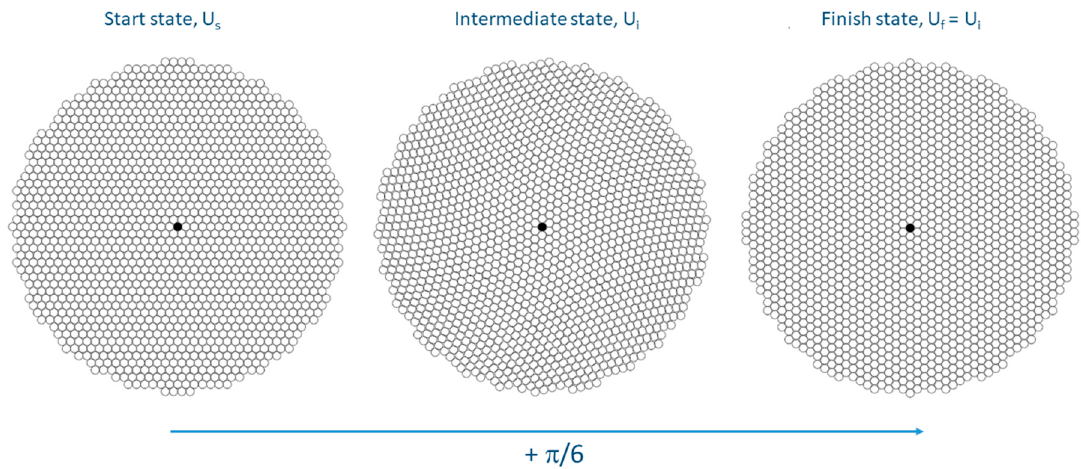
Figure 3. Rotation by 30° of 2D hexagonal crystal. The start state is at the left-hand side, with energy U s . The finish state is at the right-hand side, with energy U f = U s . In-between is an intermediate state; the energy is U i > U s . Even if the crystal is free to move, the rotation is not “instantaneous”, and the intermediate states are inevitable. In real materials, the boundaries are not completely free to move, and the retained rotation gradients remain in the crystal as in the intermediate state. They can be elastic or plastic depending on the amplitude of the rotation, the yield strength of the material, and the degree of freedom of the boundaries. In the intermediate state of the figure, the boundary was allowed to rotate by 15°, whereas the core was rotated by 30°.